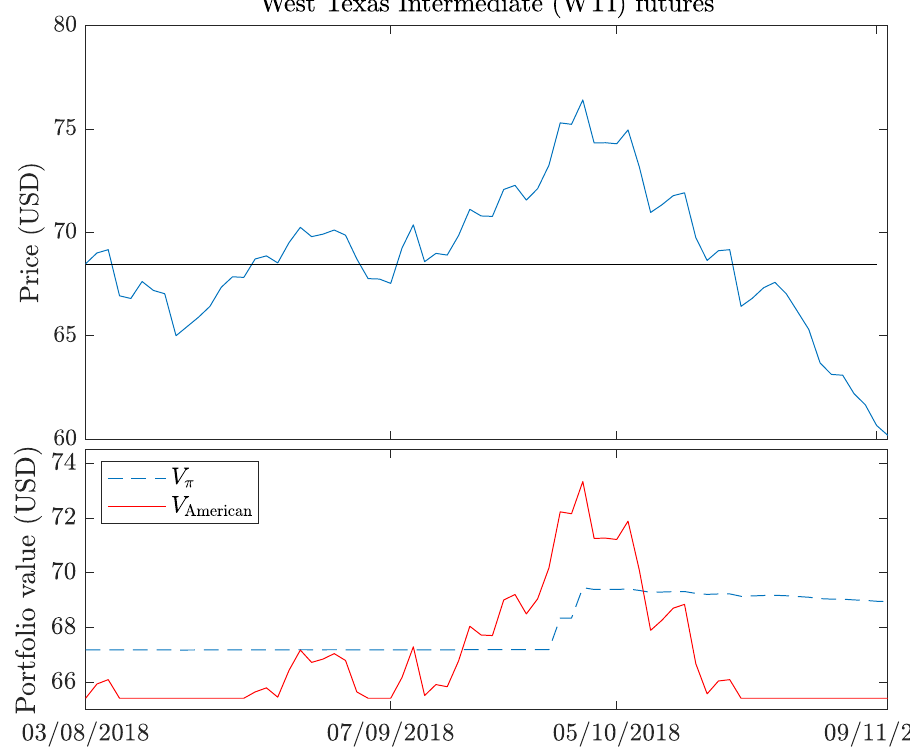
Figure 13. WTI crude oil futures contract closing prices ( top ) and payoffs of portfolios with parameters from Table 5 ( bottom